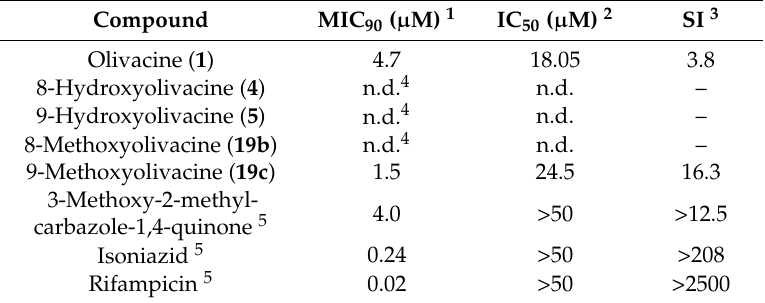
Table 2. Inhibitory activity against M. tuberculosis of olivacine ( 1 ) and its oxygenated derivatives 4 , 5 , 19b , and 19c .